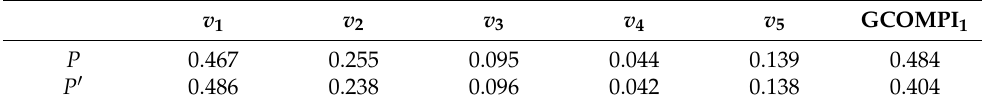
Table 3. Priorities and Compatibility for the collective